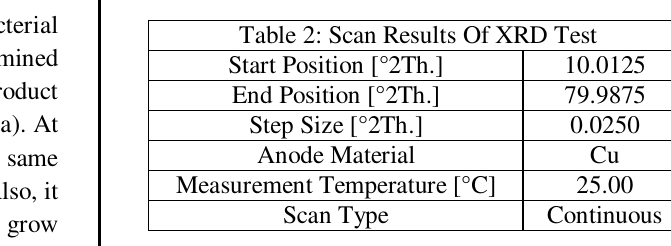
Table 2: Scan Results Of XRD